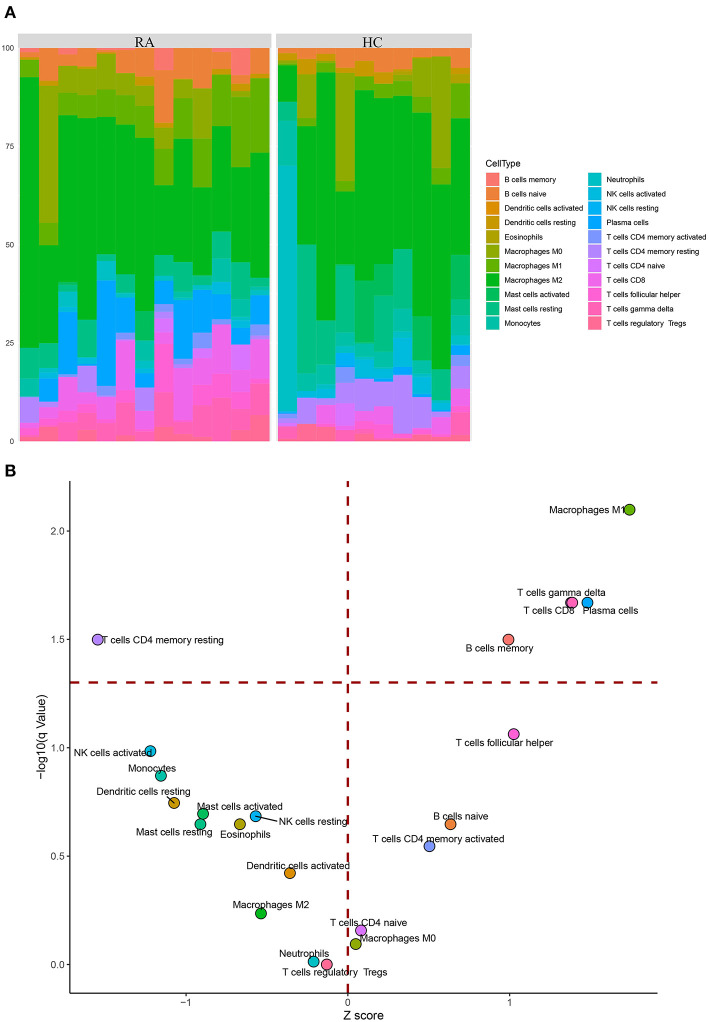
CIBER-SORT inference of immune cells composition in tissue samples. (A) Stacked barplot showing the percentages of 22 immune cell components of the RA and HC groups. (B) Volcano plot reveals distinct differences in relative compositions of immune cell populations between RA and HC samples. The y axis represents the –log10 transformation of q-value (adjusted p-value), and the red horizontal dash line indicates a q-value of 0.05.